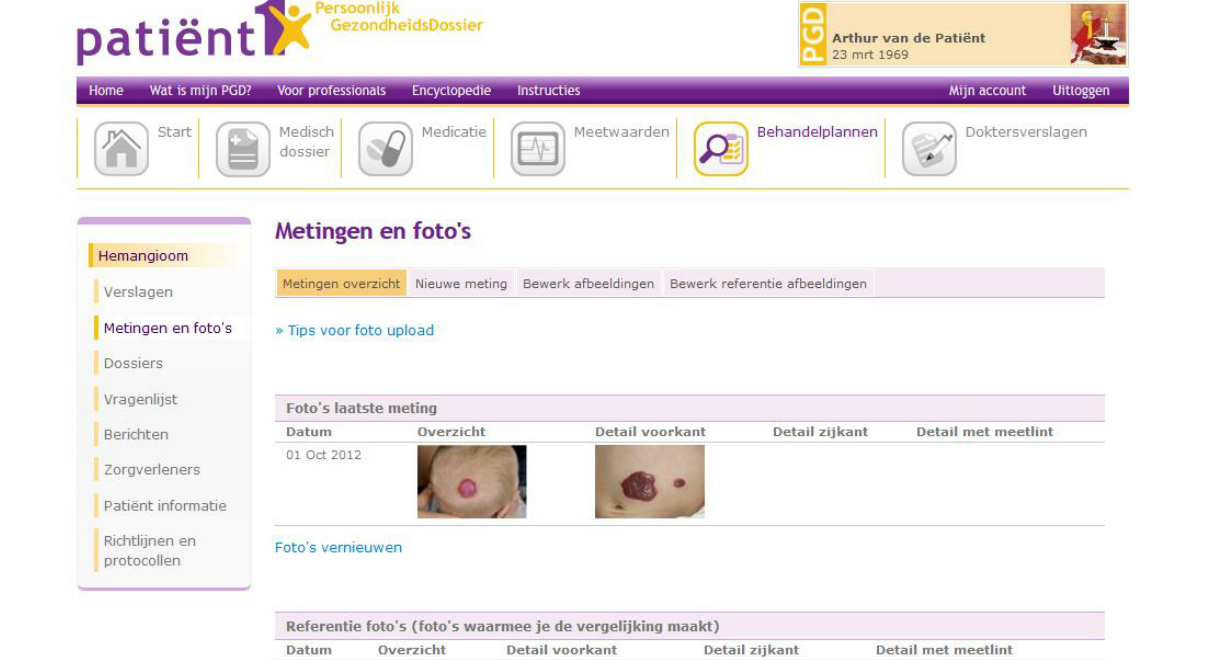
Figure 1. Screenshot of the Hemangioma Treatment Plan (in Dutch) showing the page where parents upload a photo of the hemangioma prior to consultation (fictitious patient in a test